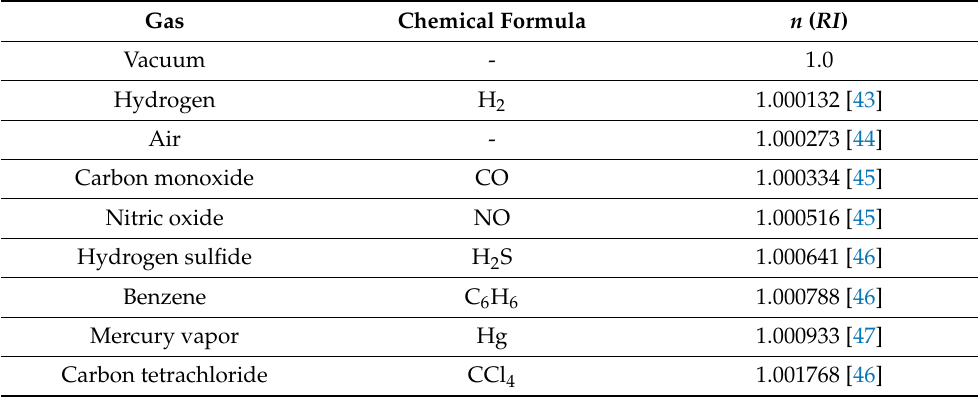
Table 1. Refractive indices of gases under the analysis.